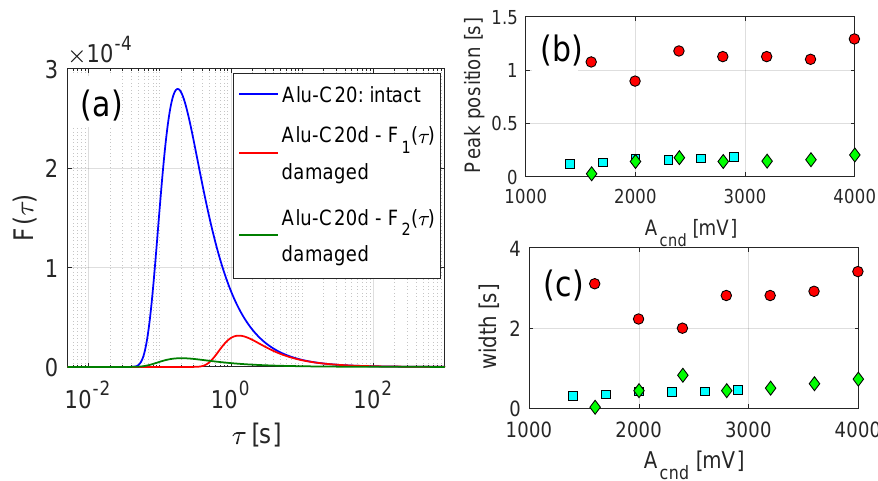
Figure 11. Effects of the presence of a closed crack. ( a ) Distribution of relaxation times for the intact and damaged samples. The latter is characterised by the sum of two distributions shown individually in the plot; ( b ) peak position vs. conditioning amplitude; ( c ) Width vs. conditioning amplitude. As expected, the two peaks of the damaged sample correspond to different length scales of the microstructural features. The lowest peak is at the same τ value as that of the intact sample, reasonably since the underlying material grain size is not modified by the presence of a localised crack. The second peak (red dots in subplots (b) and (c)) is